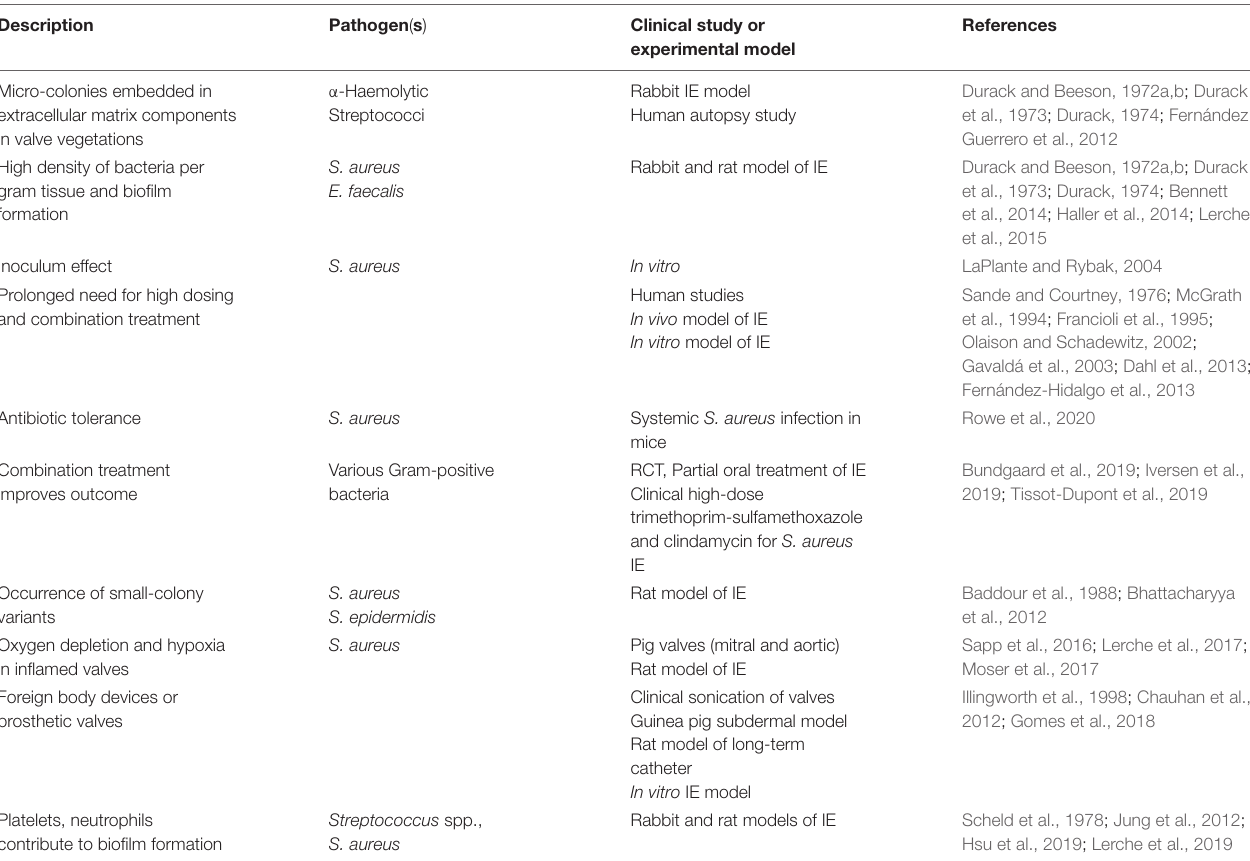
TABLE 1 | Biofilm characteristics in infective endocarditis